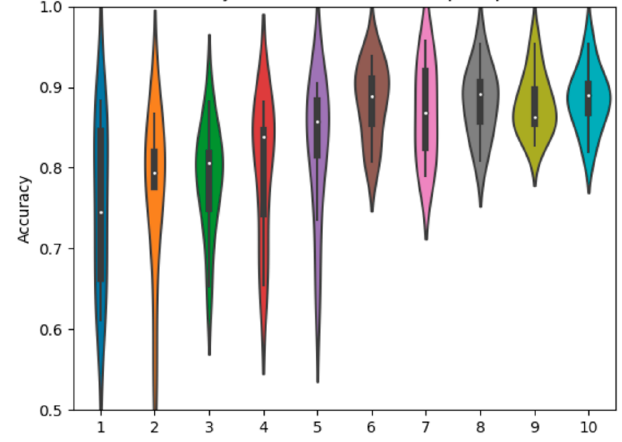
Figure 25. RGB channel fusion accuracy distributions during training by epoch.